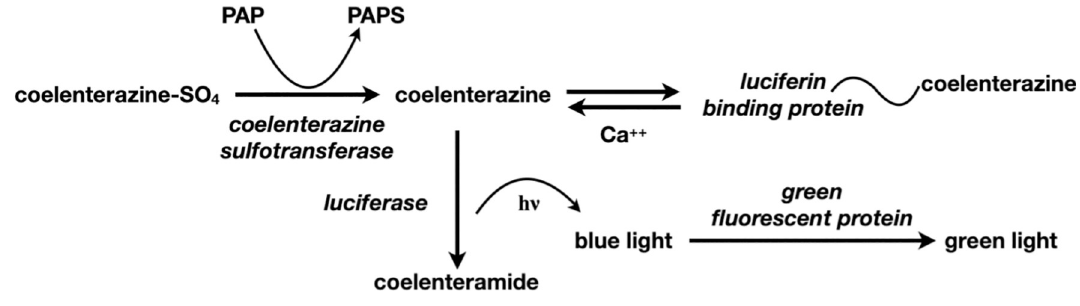
Fig 1. Renilla bioluminescence pathway.